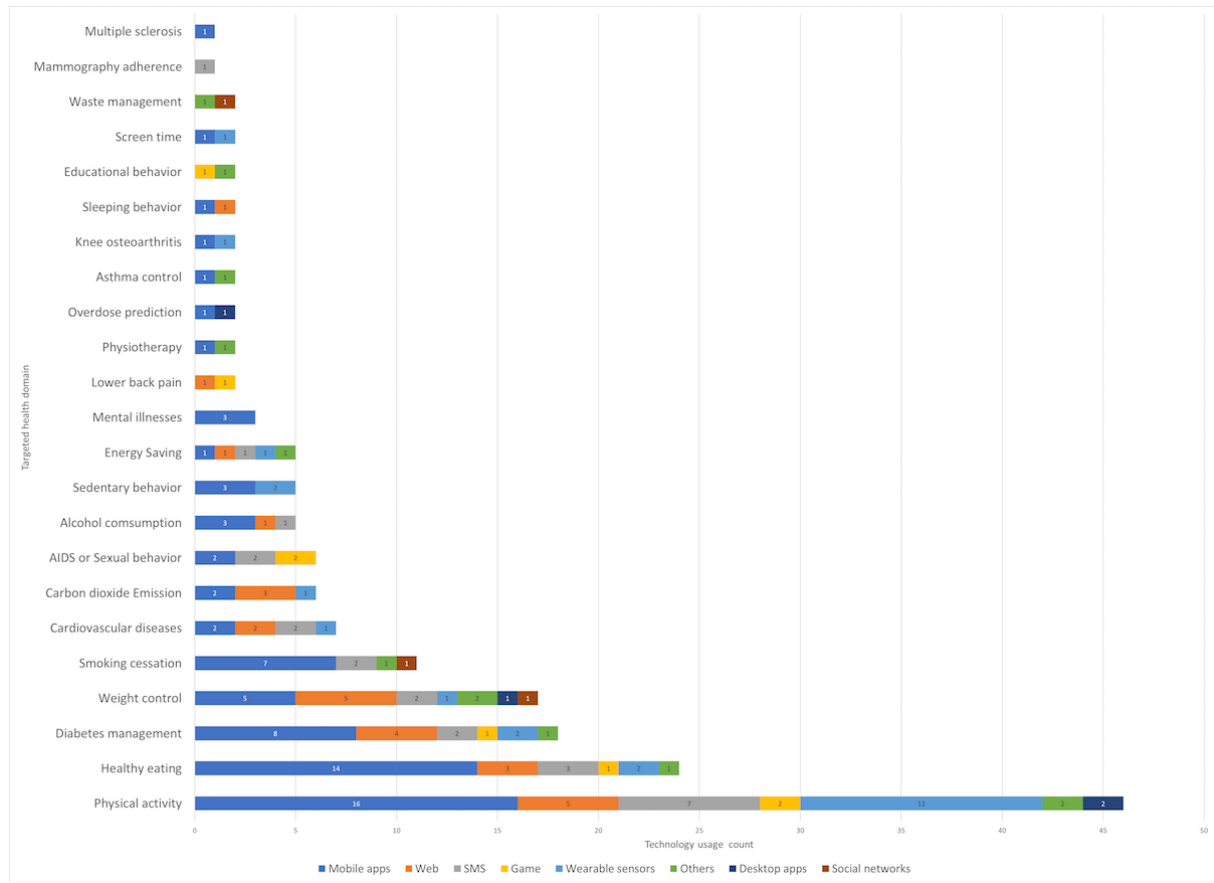
Figure 9. Bar graph representing the different targeted health domains using different technological